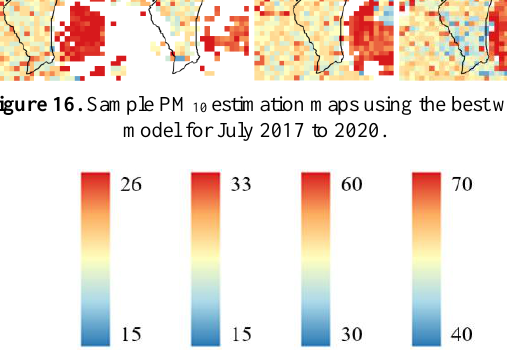
Figure 17. Map legends in µg/m 3 for PM 2.5 for March, PM 2.5 for July, PM 10 for March, and PM 10 for July (left to right). Map gradient of Blue-Yellow-Red was used to show the low to high concentrated areas of PM as shown in Figure 17. White spaces are null values due to cloud cover. Even though it is difficult to determine clusters of PM from the maps alone, PM 2.5 maps for March 2017 to 2020 show a high concentration image with a lower concentration near the central area of